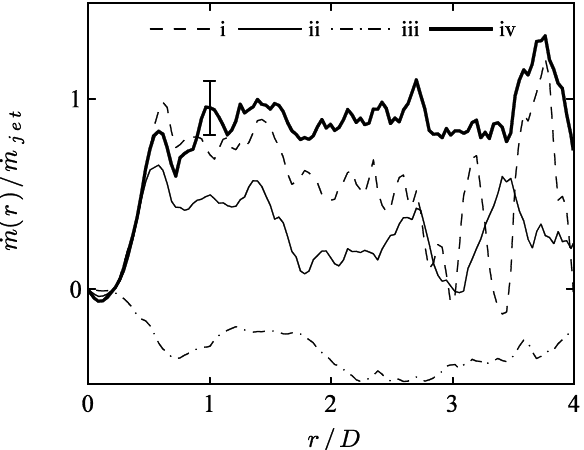
for (i-iii) conventional PIV using 𝑗𝑒𝑡 , (ii)  = 4  and (iii)  = 20  , compared to (iv) MPS min min min